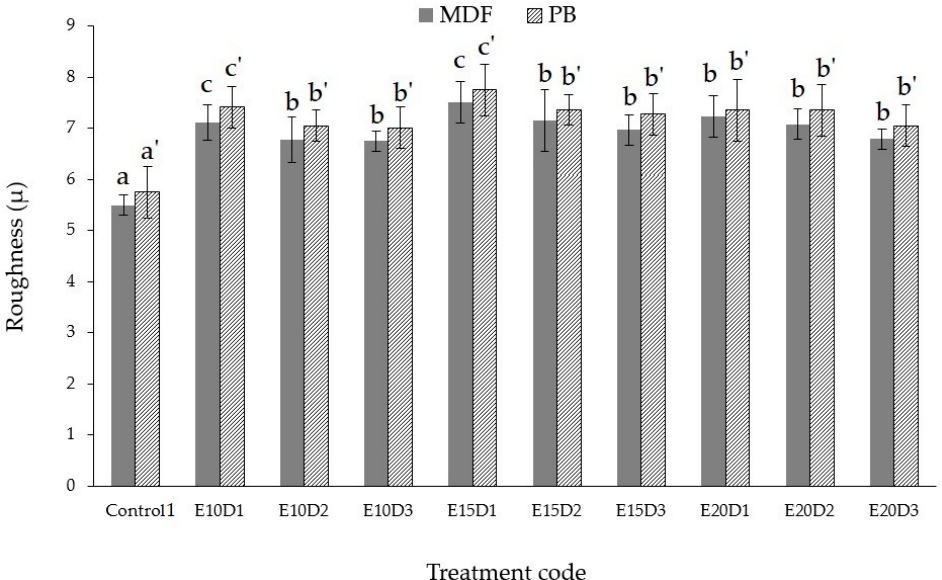
Figure 5. Surface roughness of untreated and plasma-treated PB and MDF composite panels. The statistical differences were tested with ANOVA and Duncan test, and the labelled values with the same letter were statistically equal at an error probability of α = 0.05. Error bars represent the standard deviations.